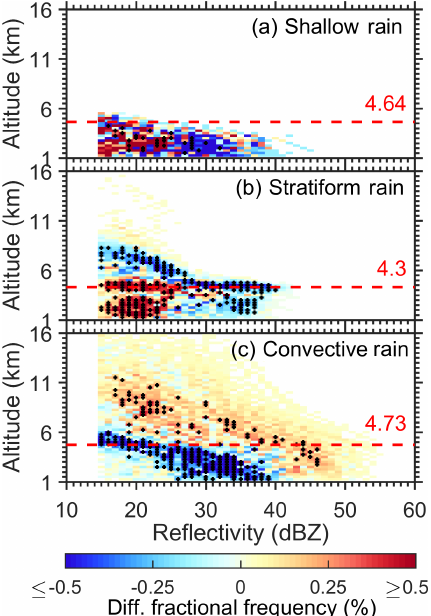
Figure 6. NCFAD showing the differences in the occurrence fre- quency for detected convective precipitation echoes (polluted mi- nus clean) for (a) light precipitation, (b) moderate precipitation, and (c) heavy precipitation. Data are from TRMM PR retrievals made during 2007–2012. The horizontal black dashed lines show the freezing level and the black crosses mark grid points where the difference exceeds the 95% significance level ( p <0.05) according to the Pearson’s χ 2